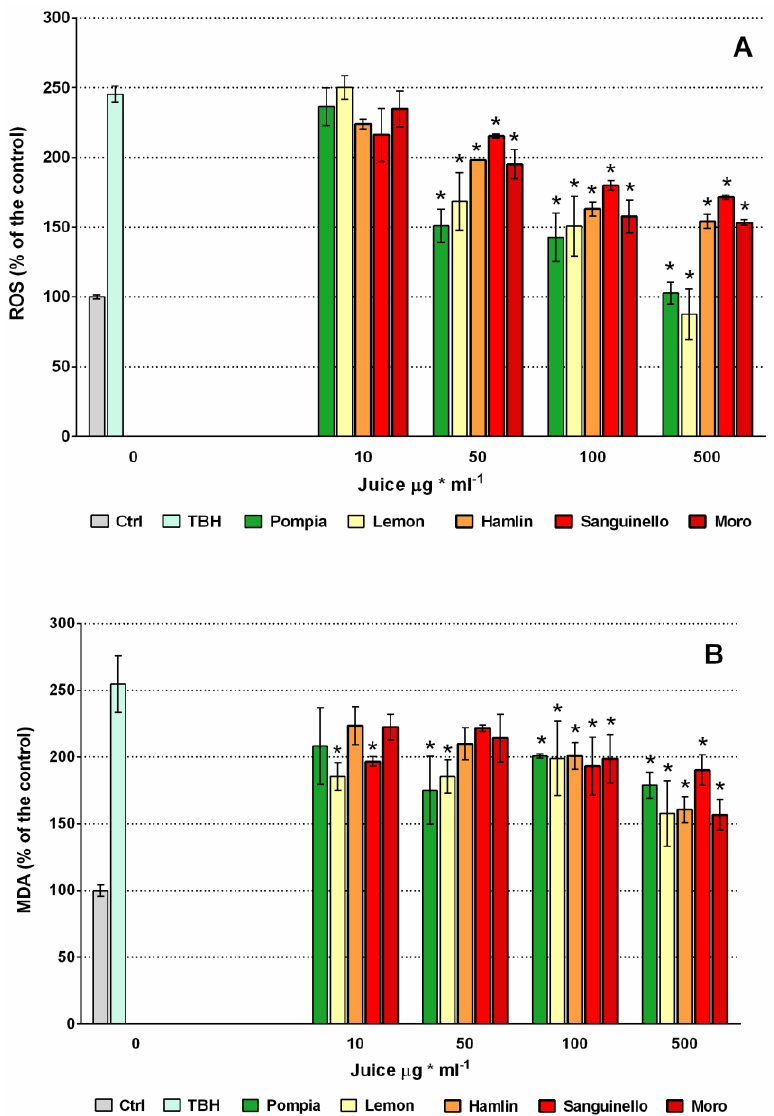
Figure 2. Evaluation of 2.5 mM TBH oxidative stress on differentiated CaCo-2 cell monolayer by determination of intracellular reactive oxygen species (ROS) production ( A ) and malonyldialdehyde (MDA) level ( B ), in the absence and in the presence of Pompia and other juices. * p ≤ 0.01 vs. TBH.